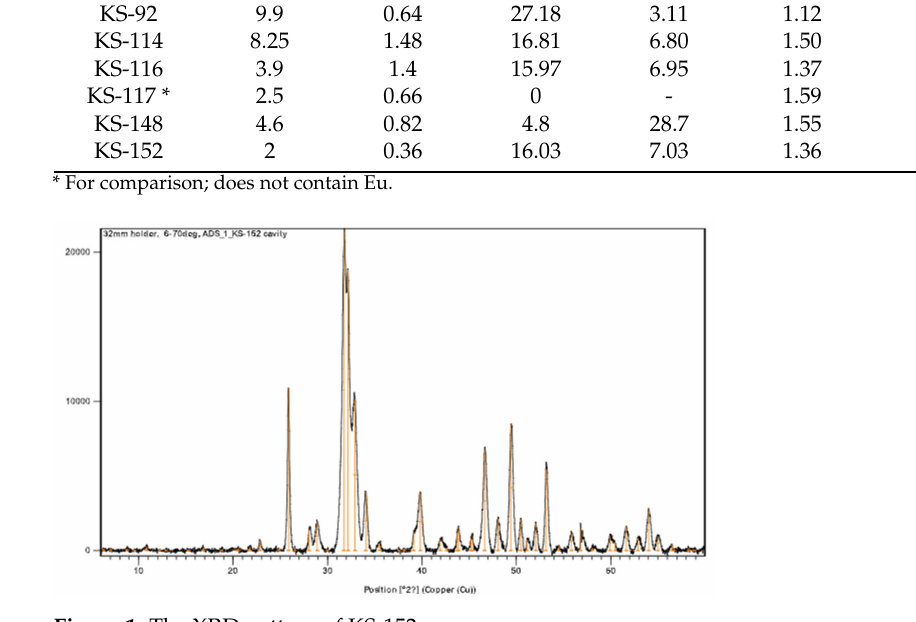
Figure 1. The XRD pattern of